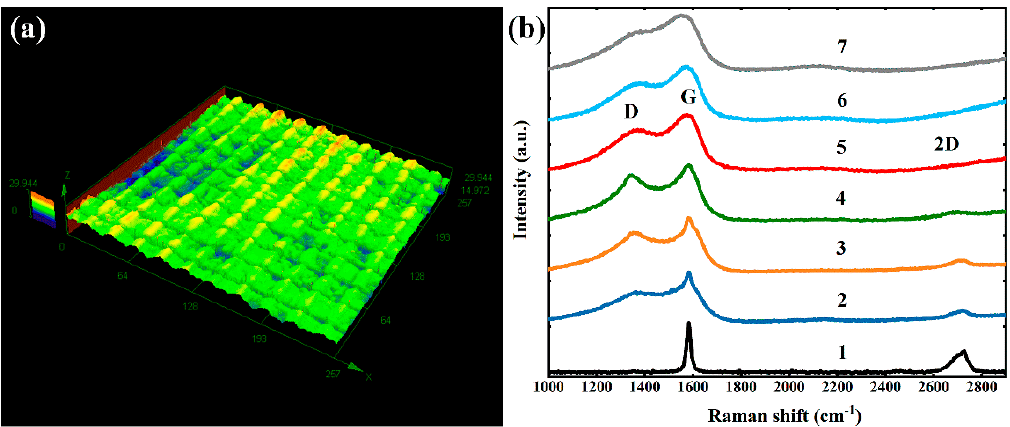
Figure 6. ( a ) Surface structure fabricated at a pulse energy of 1.52 μ J characterized by confocal laser scanning microscope and ( b ) Raman spectrum of the sample at different laser pulse energy: 1, untreated graphite surface; 2, 0.26 μ J; 3, 0.52 μ J; 4, 0.93 μ J; 5, 1.52 μ J; 6, 2.06 μ J; 7, 2.58 μ J.